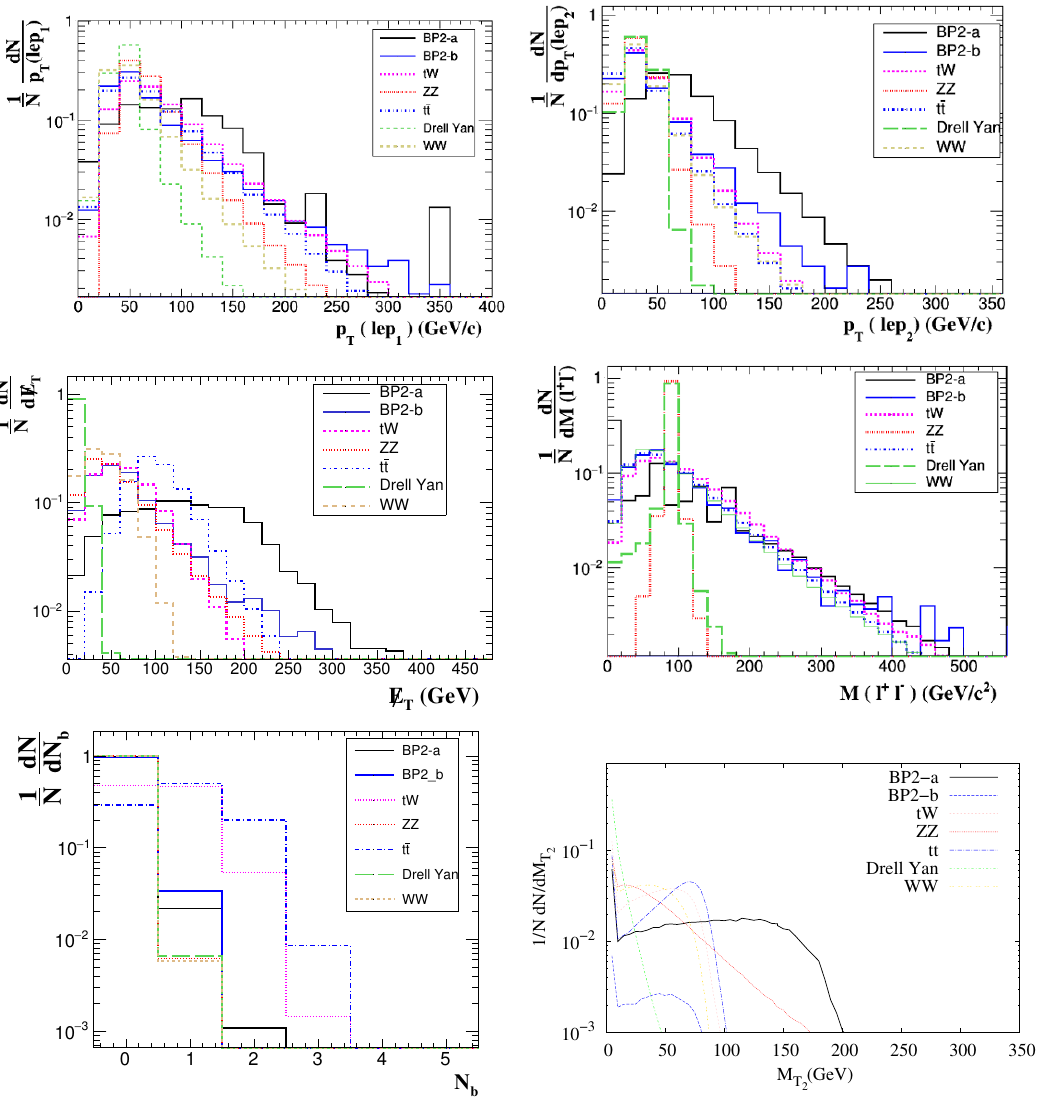
Figure 12 . Normalized distributions of several kinematic variables after cut D1